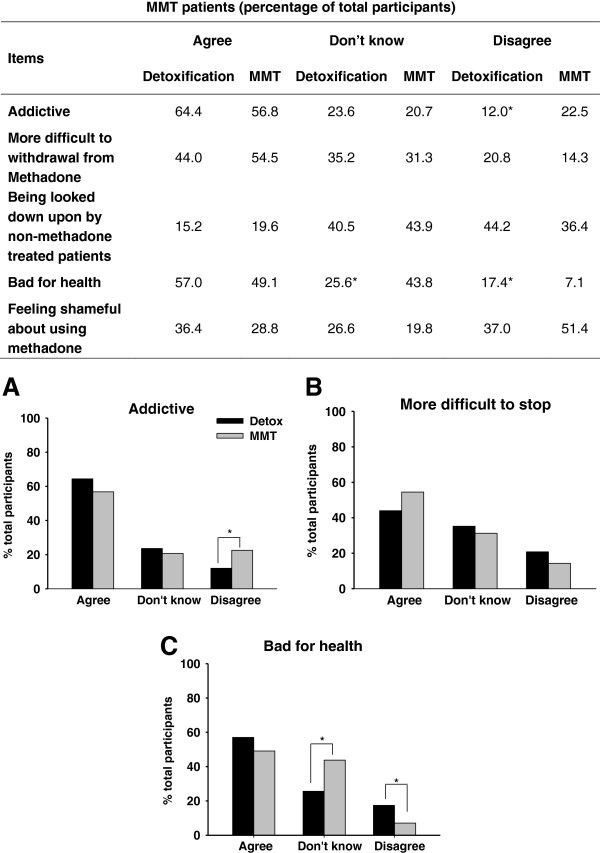
Negative attitudes toward MMT between participants at the Compulsory Detoxification Centre (black bars) and MMT patients (grey bars). Points represent the percentage of total participants agreed, didn’t know or disagreed each item of the questionnaire under “negative attitude” category. (A): Methadone is addictive (B): it is more difficult to stop using methadone; (C): Methadone is bad for health. Asterisk (*) denotes a significant difference between Compulsory Detoxification and MMT patients, p < 0.05.